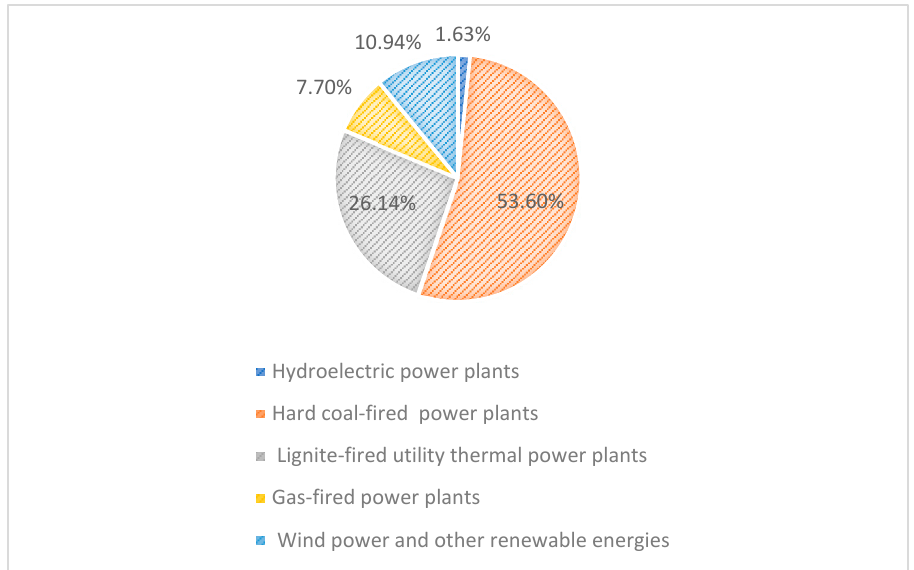
Figure 3. Structure of electricity production in domestic power plants in Poland in 2021. Source: author’s own compilation based on collective information from the 2021 Polish Power System Report